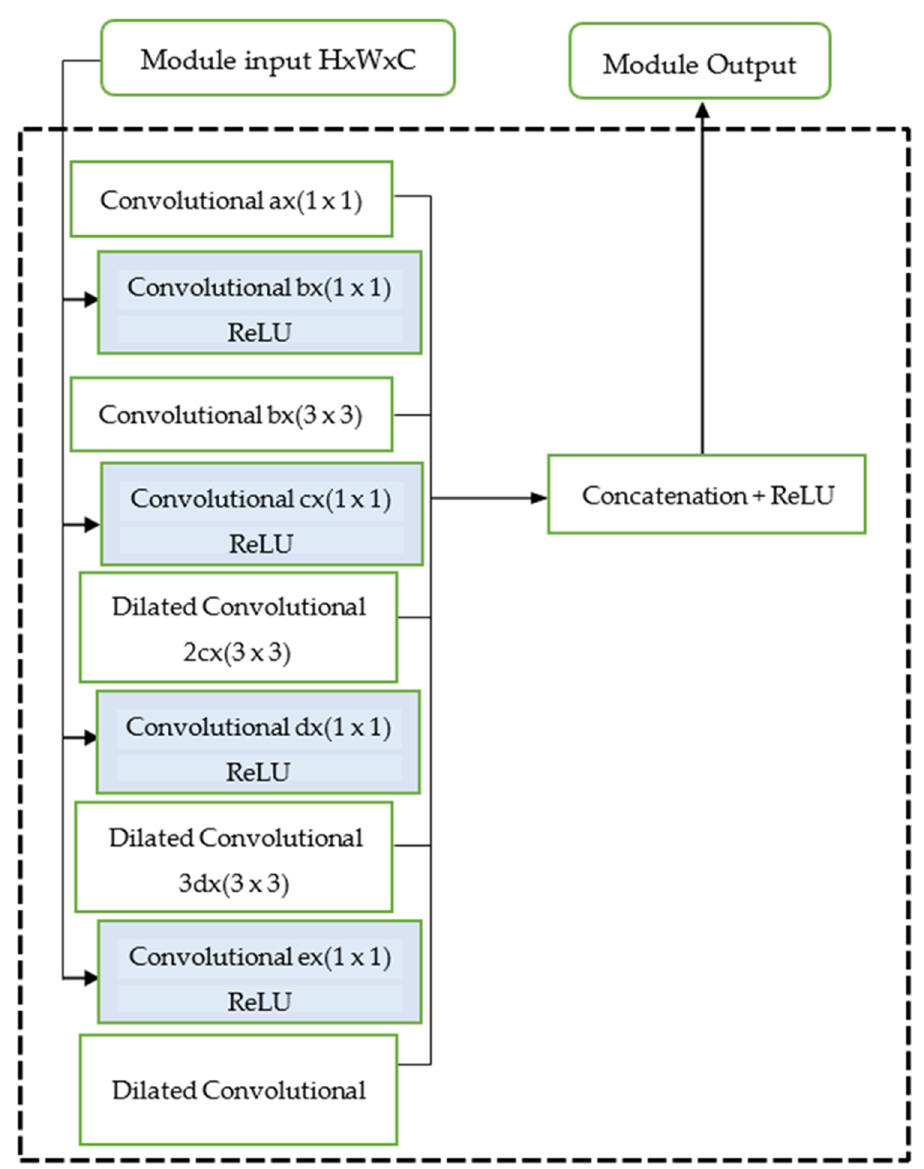
Figure 5. Proposed design architecture.